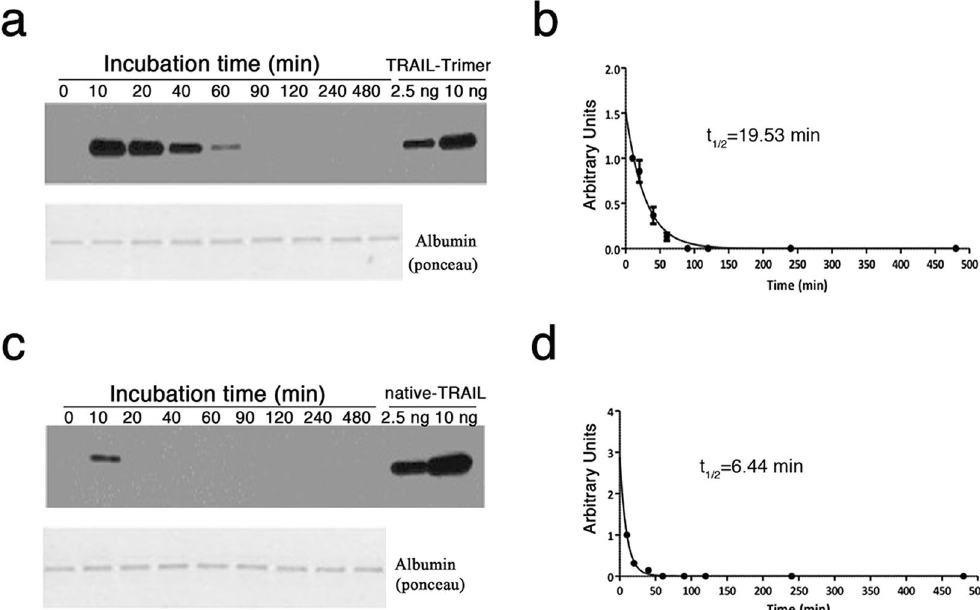
Figure 5. Pharmacokinetic profile of TRAIL-Trimer and native TRAIL determined by western blot. Mice were injected intravenously with equimolar amounts of TRAIL-Trimer (40 mg/kg) or native TRAIL (15 mg/ kg) (n = 3 for each protein). ( a , c ) Relative serum concentrations of both TRAIL-Trimer ( a ) and native TRAIL ( c ) were evaluated at periodic intervals by western blotting. TRAIL proteins were immunoblotted with an antibody against human TRAIL, and visualized by chemiluminescence. The images were acquired using the ChemiDoc Touch Imaging System (Bio-Rad) and the quantification of the amount of TRAIL proteins present in each sample was done using Image Lab software (Bio-Rad). ( b , d ) Estimated half-lives of TRAIL-Trimer ( b ) and native TRAIL ( d ) were calculated using GraphPad Prism v5.04. Error bars represent ± SEM.